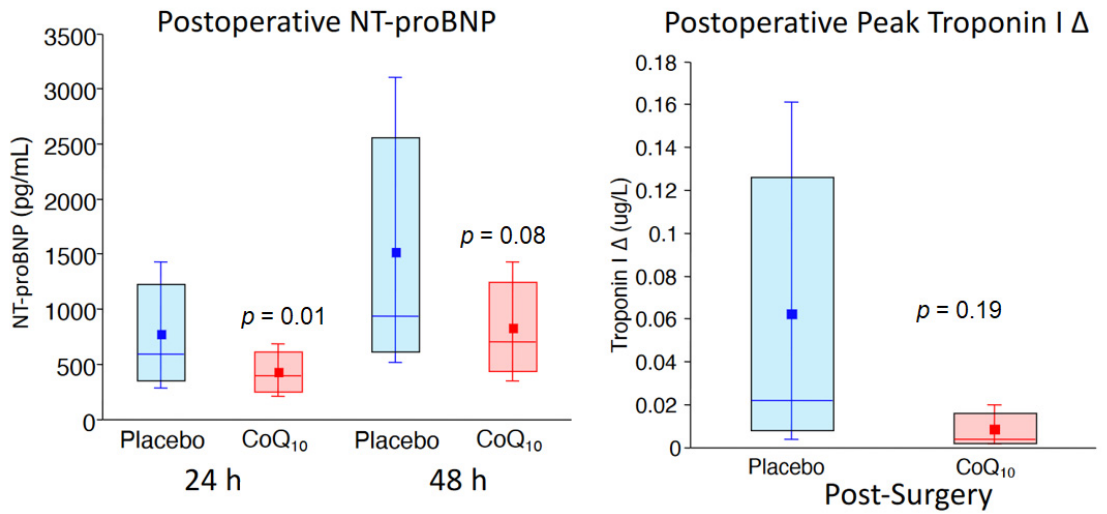
Figure 2. Patients were randomized to either coenzyme Q 10 (CoQ 10) ( n = 62) or placebo ( n = 61) for 3 days before elective vascular surgery, and as shown, NT-Pro BNP levels were lower with treatment. The degree of injury, as defined by the change (delta) in troponin I levels from baseline to peak postoperative level, was higher in the placebo compared with that of the CoQ 10 treatment group [2]. Values are expressed as medians, interquartile values, and means. Permission was granted to reproduce the